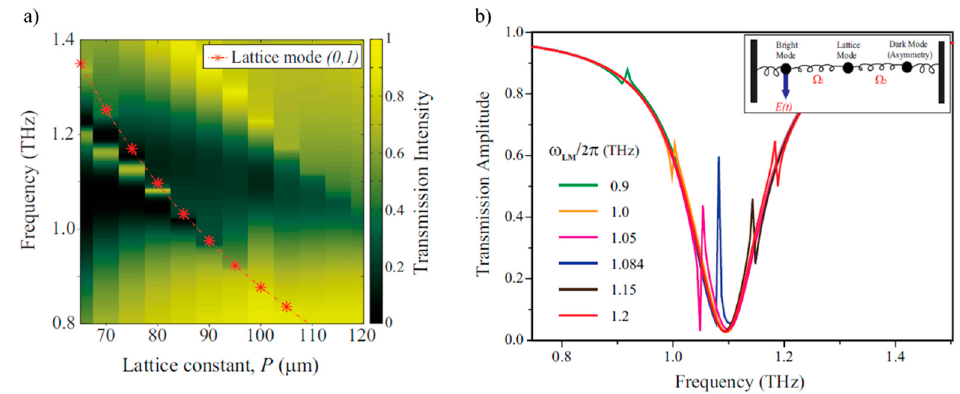
Figure 5. Lattice-induced transparency. ( a ) Transmission around a LIT resonance as a function of frequency and lattice constant for split rings as in Figure 4I. The red dashed-dot curve indicates the first order lattice mode (0,1). ( b ) Transmission amplitude of the associated resonances extracted from the three-oscillator model of Equation (4) for varying lattice mode frequencies. For lattice modes in a silicon substrate, (cid:3104) (cid:3261)(cid:3262) 2 π (cid:2870)(cid:3095) = 0.9,1.084 and 1.2 THz correspond to lattice periods of P = 95, 80 and 65 μm , respectively. The schematic shows the underlying classical bright-dark-dark coupled oscillator model. Adapted with permission from ref [35], American Physical Society.